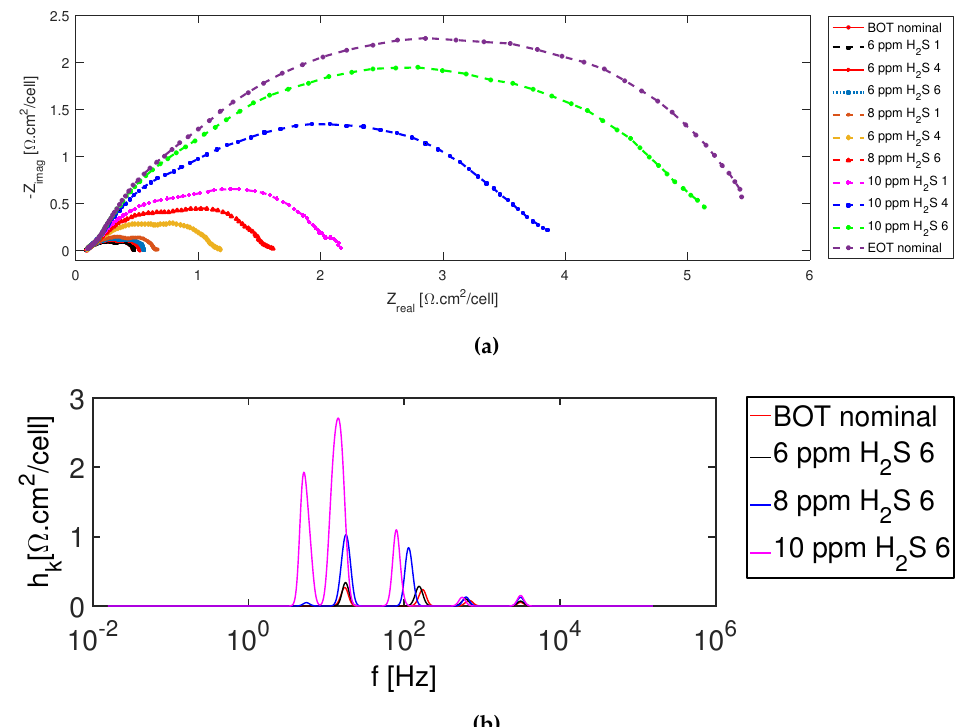
Figure 8. Sulfur poisoning at 40 A (second fuel cell stack): ( a ) impedance spectra; ( b ) DRT analysis. The numbers on the right-hand side of H 2 S in the legend indicate the run numbers for the set point, and the last spectrum of each set point (Spectrum 6) was selected for the DRT